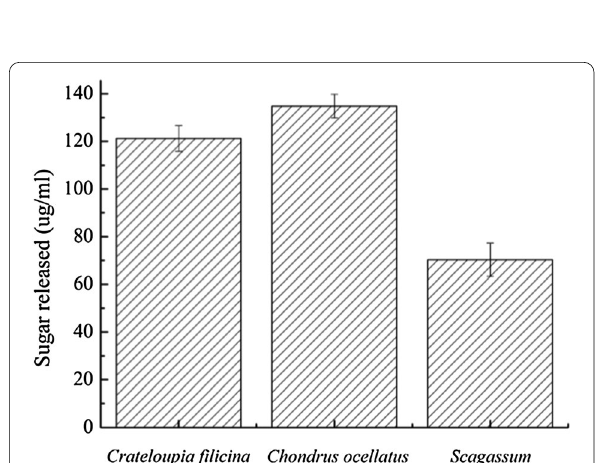
Fig. 7 Reducing sugars released during Amy2587 degradation of three seaweed substrates, Grateloupia filicina , Chondrus ocellatus , and Scagassum , after 12 h, 6 h, and 24 h,